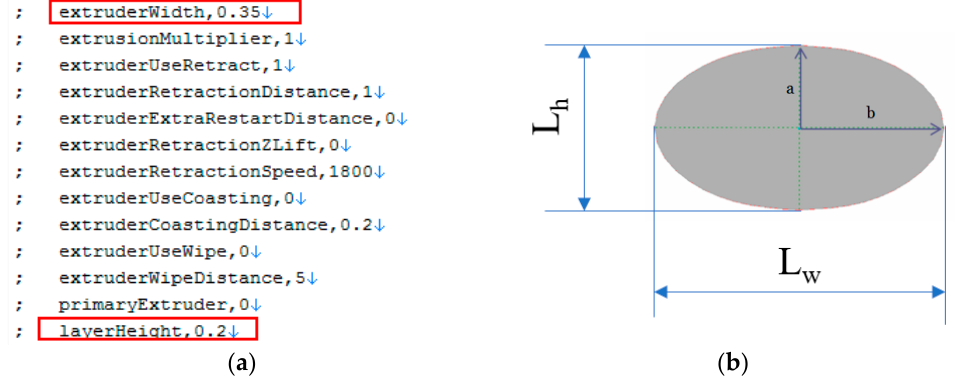
Figure 2. Printed filaments geometry: ( a ) Segment form the printed G-code; ( b ) Theoretical dimen- sions of a fiber (L w and L h correspond to extruder Width and layer